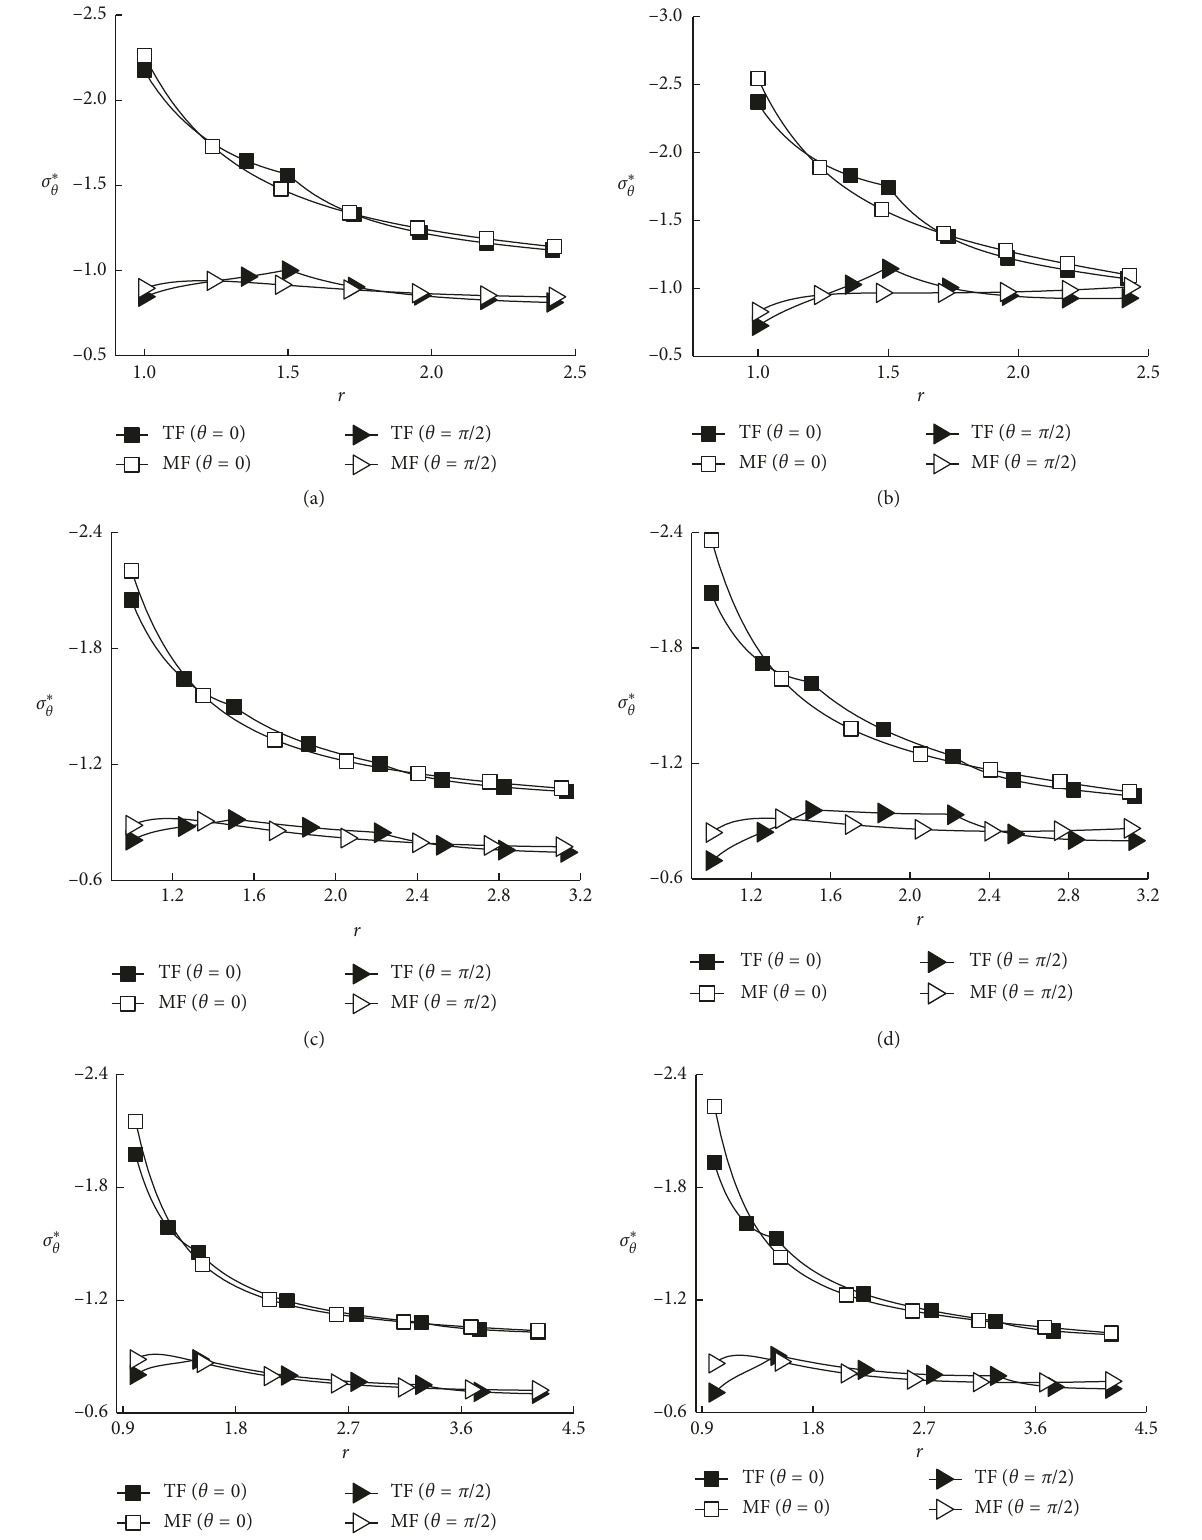
Figure 9: Distribution graphs of σ ∗ - r : (a) single-circle pipes and rock freezing; (b) single-circle pipes and soil freezing; (c) double-circle θ pipes and rock freezing; (d) double-circle pipes and soil freezing; (e) triple-circle pipes and rock freezing; (f) triple-circle pipes and soil